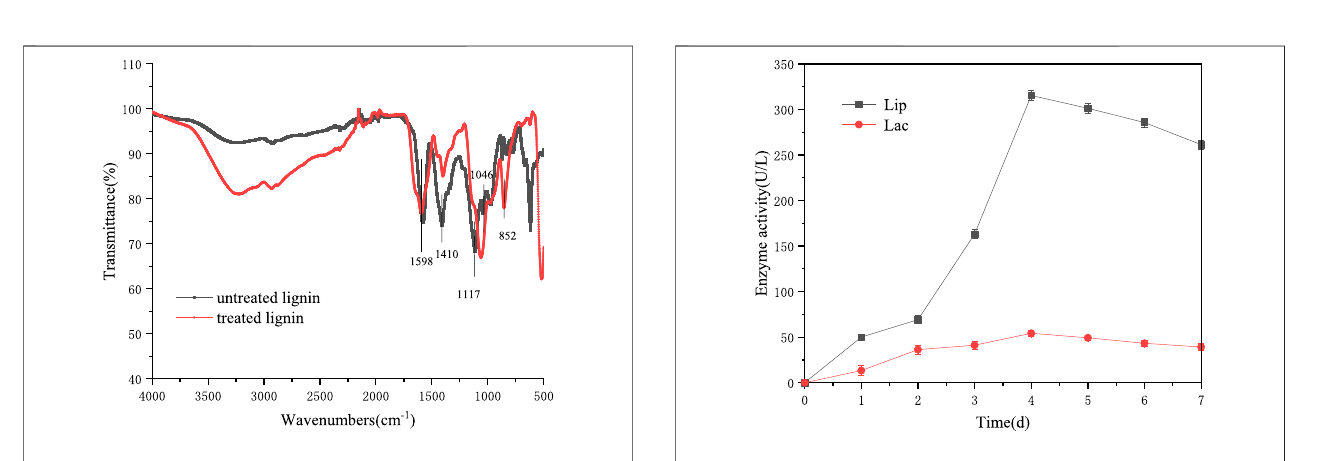
FIGURE 6 | FTIR spectrum of alkali lignin before and after biodegradation with Bacillus subtilis TR-03.